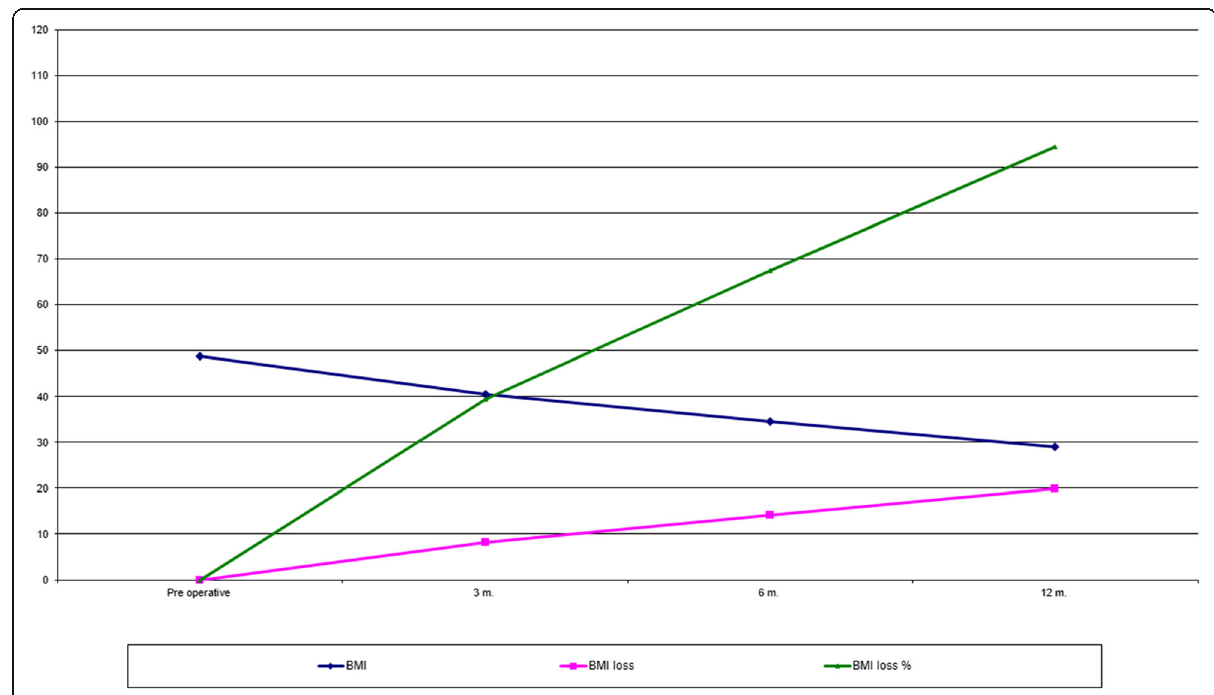
Fig. 2 Simultaneous changes of BMI, BML, and BML% of our